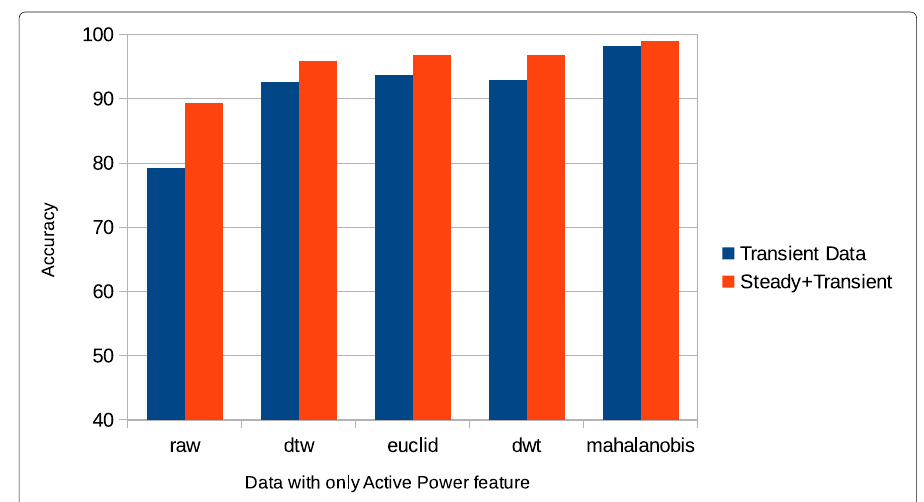
Fig. 8 Performance of steady+transient feature fusion based RF classifier with transient feature based RF classifier with only Active Power feature